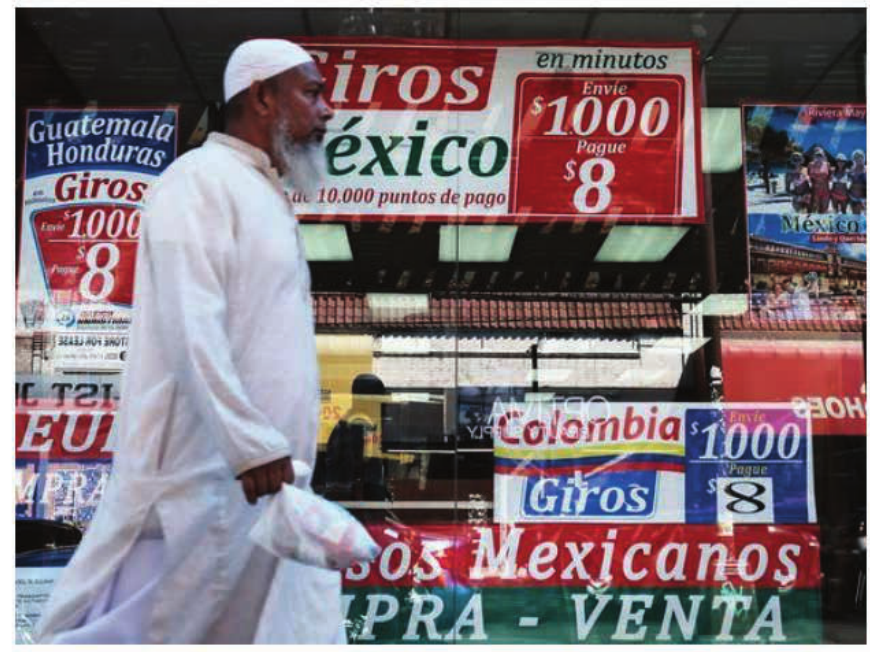
Figure 6: A Muslim man walks by a Latino store in Queens. (Photo: Spencer Platt, Getty Images) (UST), http://www.usatoday. com/story/opinion/2016/08/31/trump-immigration-legal-wall-visas-green-cards-australia-canada-column/89585370/ (date of last access: